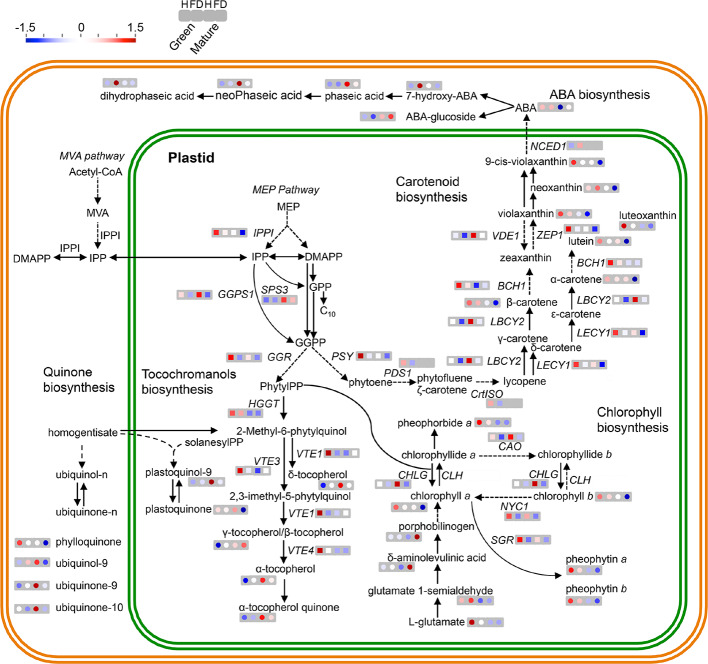
MapMan schematic representation of isoprenoid metabolic pathways in leaves of healthy (H) and flavescence dorée-infected (FD) vines cv. ‘Loureiro’. Simplified representation of metabolite biosynthesis steps and expression of key genes of the following pathways: MVA pathway in the cytosol or the methylerythritol 4-phosphate (MEP) pathway in plastids responsible for the synthesis of isoprenoid precursors isopentenyl diphosphate (IPP) and dimethylallyl diphosphate (DMAPP) and the expression of terpenoids backbone biosynthetic pathway genes VvIPPI, VvSPS3, VvGGR and VvGGPS; carotenoids biosynthetic pathway metabolites and the expression of VvPSY, VvPSD1, VvCrtISO, VvLBCY2, VvLECY1, VvBCH1, VvVDE, VvZEP1 and VvNCED1 genes; ubiquinone and other terpenoid-quinone biosynthetic pathway metabolites and the expression of VvHGGT, VvVTE1, VvVTE3 and VvVTE4 genes; porphyrin and chlorophyll biosynthetic pathway and the expression of VvCHLG, VvCAO and VvNYC genes. Metabolites content (circles) and transcript expression (squares) variation between healthy (H) and infected (FD) grapevines are represented by a colored scale: red—up regulated, blue—down regulated in both developmental stages (green and mature) from left to right, respectively. Grey squares represent a gene with no detected expression in that developmental stage or condition. Dashed arrows indicate multiple metabolic steps. Significant differences between FD-infected and respective controls are shown in Figure 3 and Supplementary Table S4.